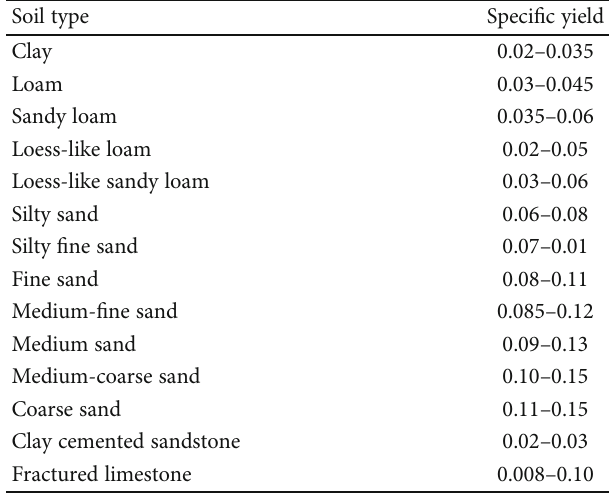
Table 1: Empirical values of the speci fi c yield for various types